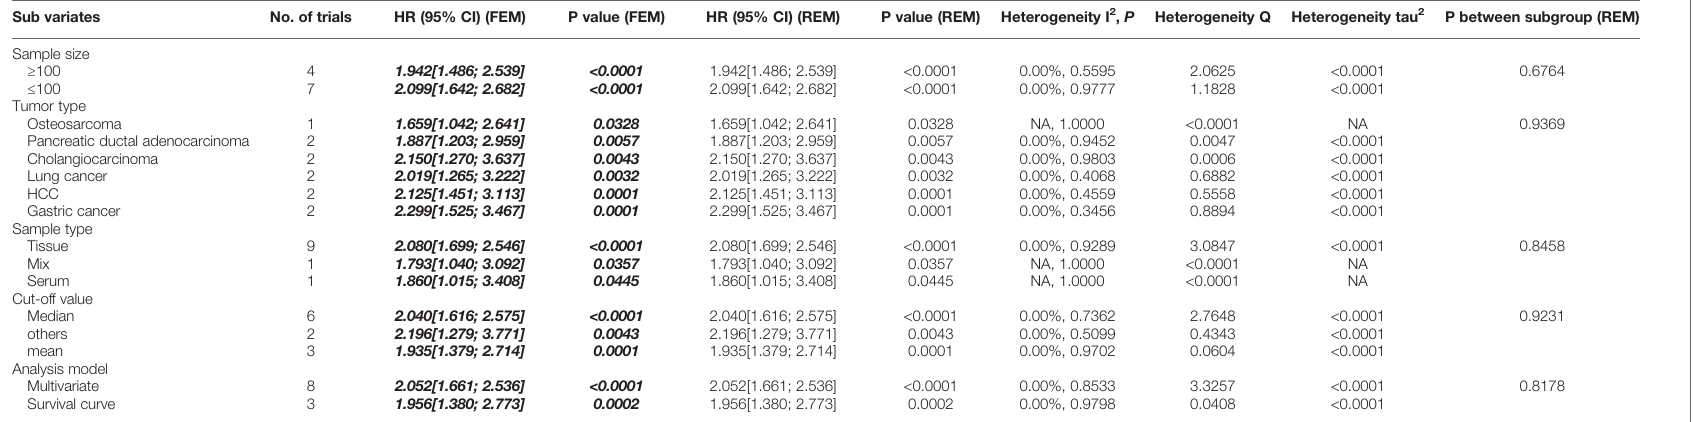
TABLE 4 | Subgroup analysis of the association between SOX2-OT overexpression and OS in patients with different cancers. Sub